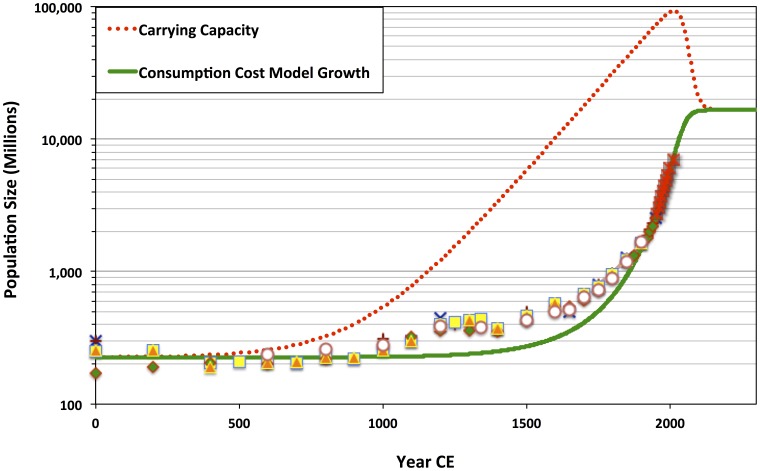
Consumption-cost (CC) model trajectory for the case involving ; ; ; ; and .See Table 3 for additional details.